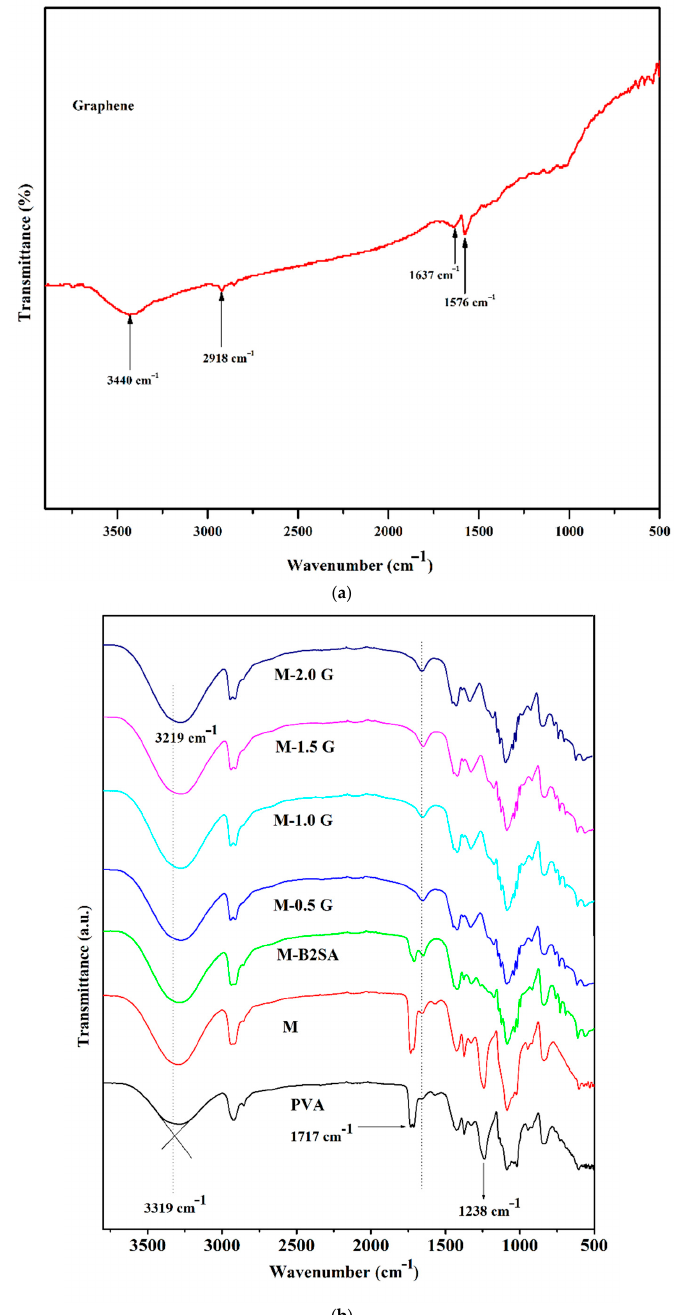
Figure 3. ( a ) FTIR spectra of plane graphene. ( b ) FTIR spectra of PVA; PVA–TEOS (M); sulfonated PVA–TEOS (M-B2SA); and graphene-loaded, sulfonated PVA–TEOS hybrid membranes: (M-0.5 G) 0.5 mass%; (M-1 G) 1 mass%; (M-1.5 G) 1.5 mass%; (M-2 G) 2 mass% of